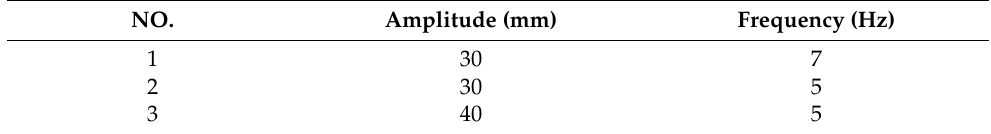
Table 1. Amplitude and frequency combinations used in transient simulation and testing.